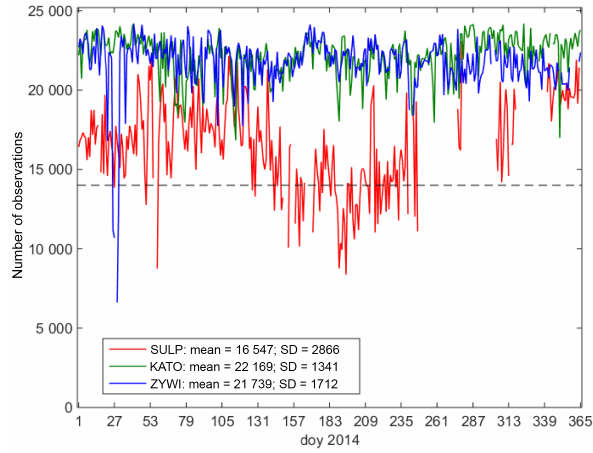
Figure 5. Time series of the number of observations (or maximum when the station is involved in several baselines) for stations SULP, KATO, and ZYWI. The dashed line shows the threshold used to eliminate days with low numbers of